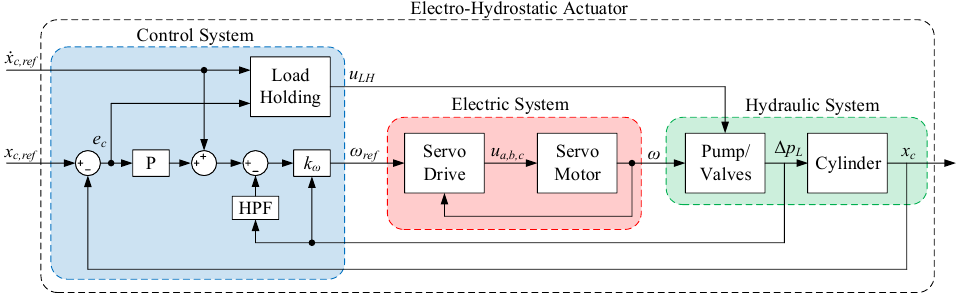
Figure 10. Overview of the EHA with control system, electric system, and hydraulic system.